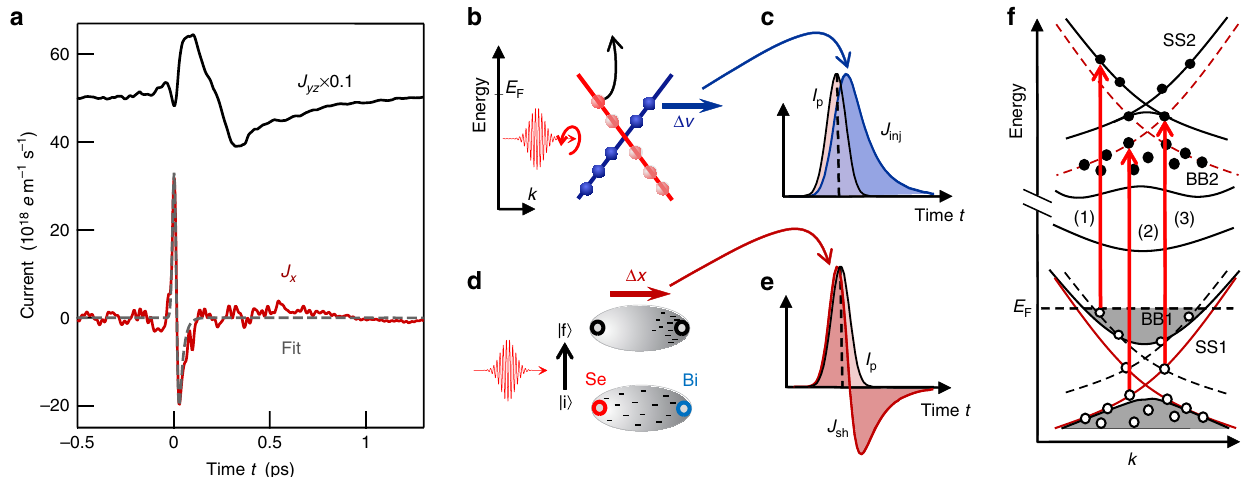
Figure 4 | Extracted photocurrents and their assignment. ( a ) Source currents of the two dominant signal components (see Fig. 3). The dynamics of these currents allow us to reveal the origin of the photocurrent. Curves are offset for clarity. ( b ) Example of an injection-type photocurrent. The pump pulse promotes electrons from the Dirac cone into other bands, thereby changing the electron band velocity. An asymmetric depopulation of the Dirac cone and, thus, nonzero net current is achieved by using circularly polarized light 6 . ( c ) Typical shape of the resulting photocurrent J inj ( t ). Here, I p ( t ) is the intensity envelope of the laser pulse. ( d ) Scenario of a shift photocurrent arising from an ultrafast transfer of electron density along the Se–Bi bond. ( e ) Typical bipolar temporal shape of the resulting sheet current J sh ( t ). ( f ) Schematic of the electronic band structure of Bi 2 Se 3 . While BB1/BB2 represent bulk bands below/above the Fermi level E F , SS1/SS2 refer to surface states. Red arrows indicate three examples of pump-induced optical transitions (photon energy of B 1.5eV). To better illustrate the excitation process, thin black/red lines indicate copies of SS1/SS2 shifted upwards/downwards by the pump photon energy. Ground-state occupation is displayed